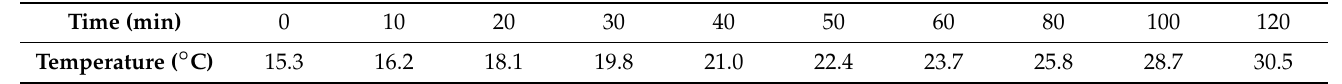
Figure 20. Electric heating test of rut plate specimen. Table 19. Temperature rises test results of specimens with 0.3% carbon fiber + 0.5% graphene con- tent.